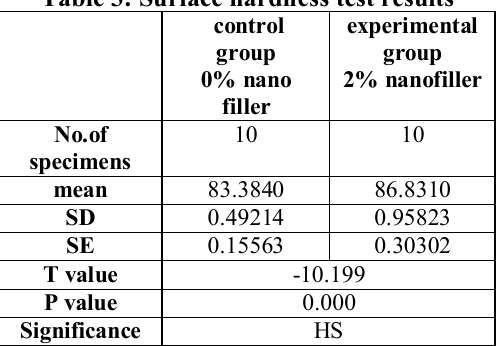
Table 3: Surface hardness test results